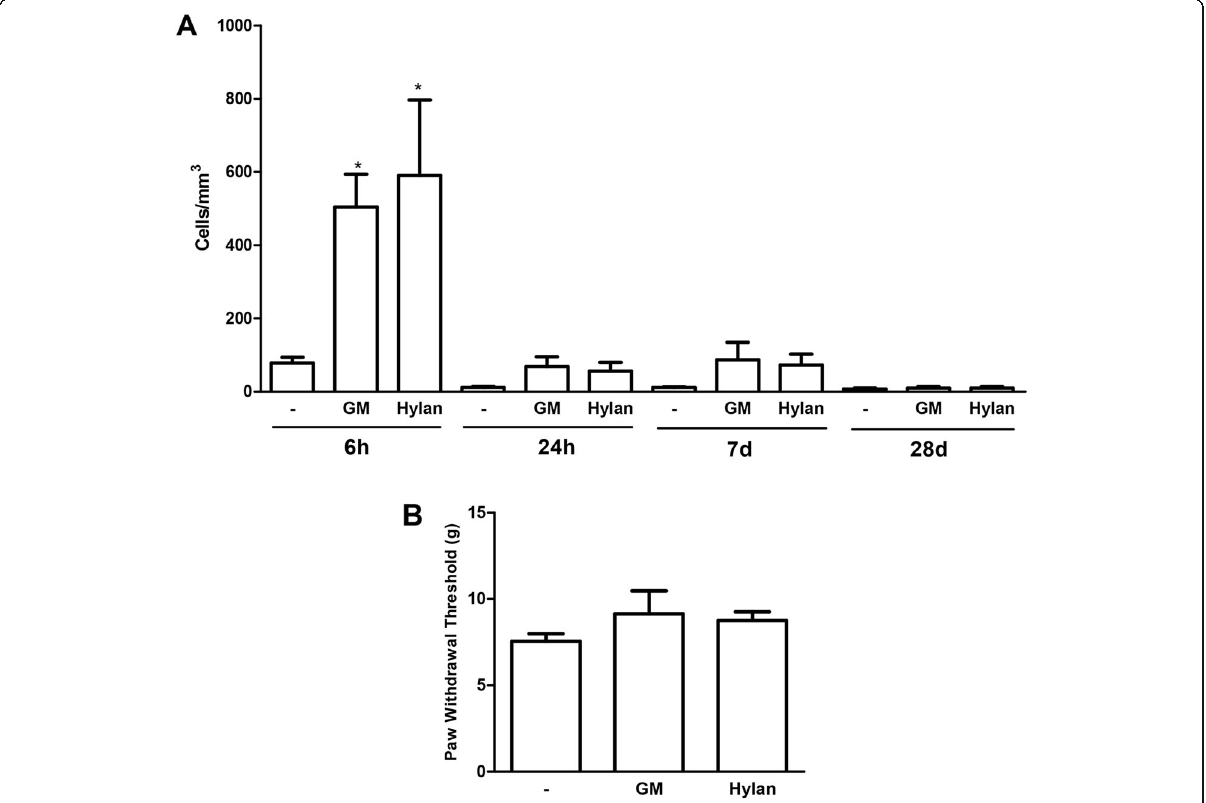
Fig. 1 Guar gum (GM) or Hylan G-F20 (HY) (100 μ g/25 μ L) or 25 μ L saline were injected into naïve mouse joints; a kinetics of total leukocyte counts in joint lavage; b Joint pain evaluated at 5 h post-injection, using von Frey test. Data are mean ± SD of n = 6/group; one-way ANOVA followed by Tukey ’ s